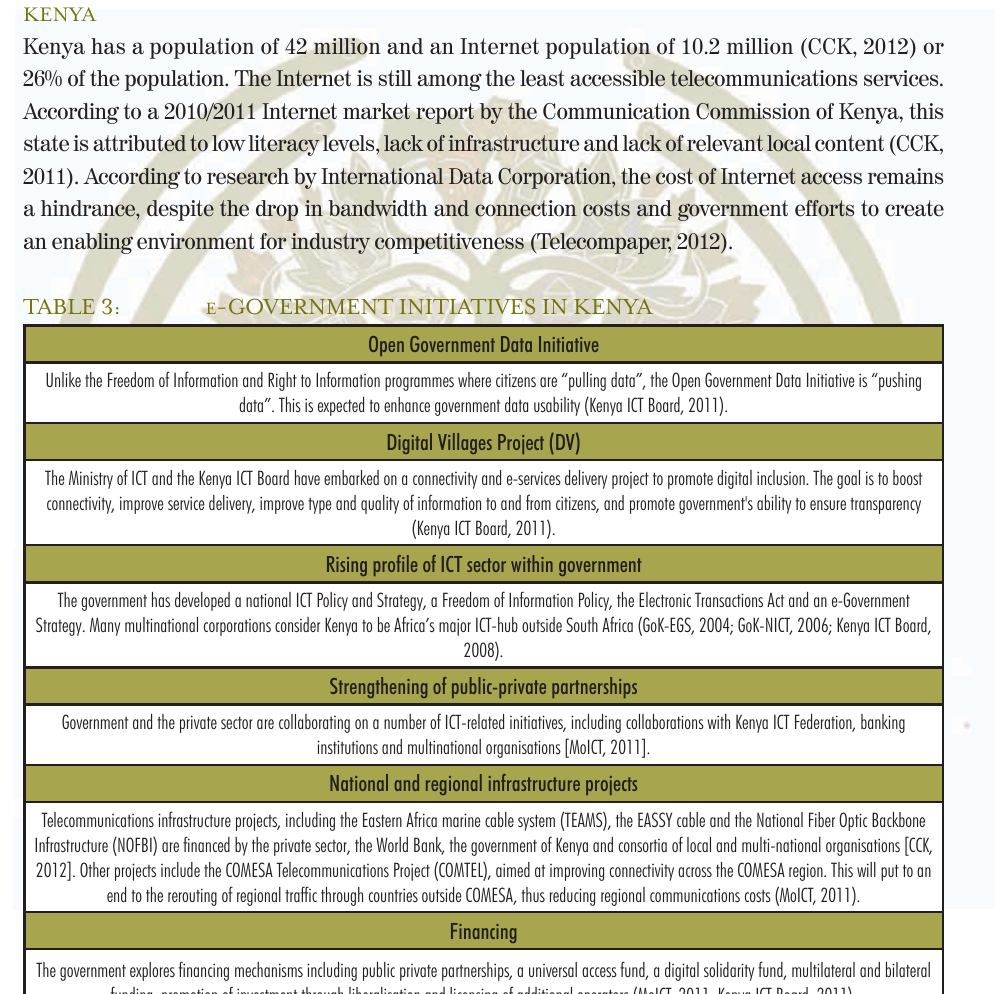
E -GOVERNMENT INITIATIVES IN